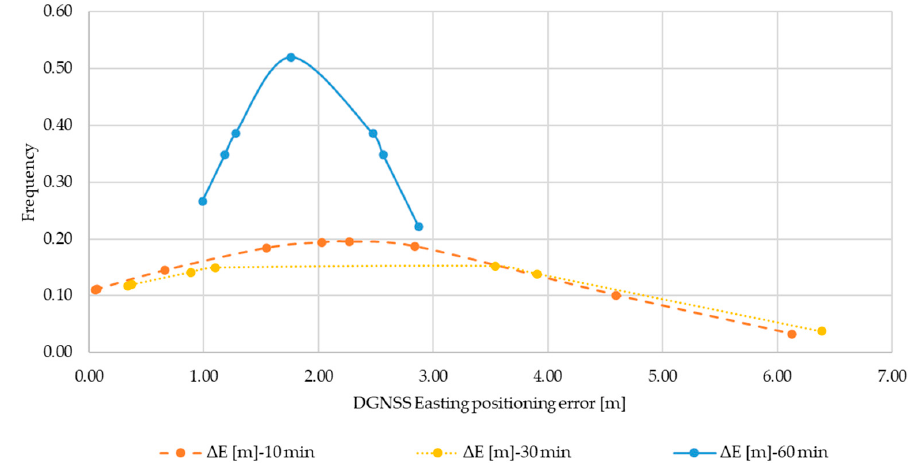
Figure A1. Normal distribution ∆ E for DGNSS.